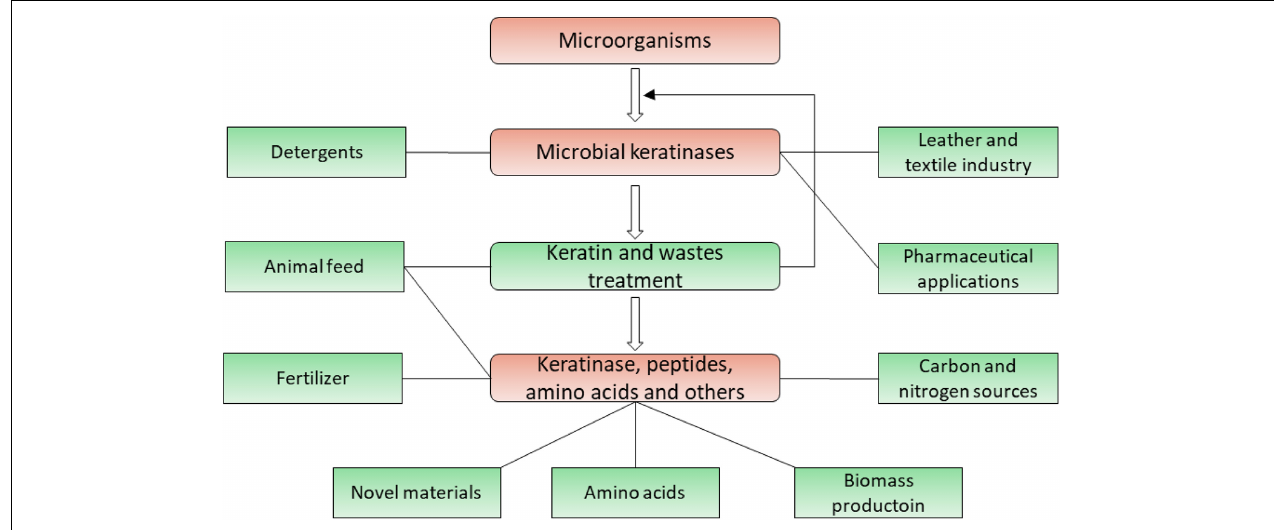
FIGURE 5 | Application of microbial keratinases in different fields. Applications of keratinases and their products are highlighted in green, which has been introduced in multiple reports (Onifade et al., 1998; Gupta and Ramnani, 2006; Brandelli et al., 2010; Chaturvedi et al., 2014; Sahni et al., 2015; Sharma and Gupta, 2016; Vidmar and Vodovnik,